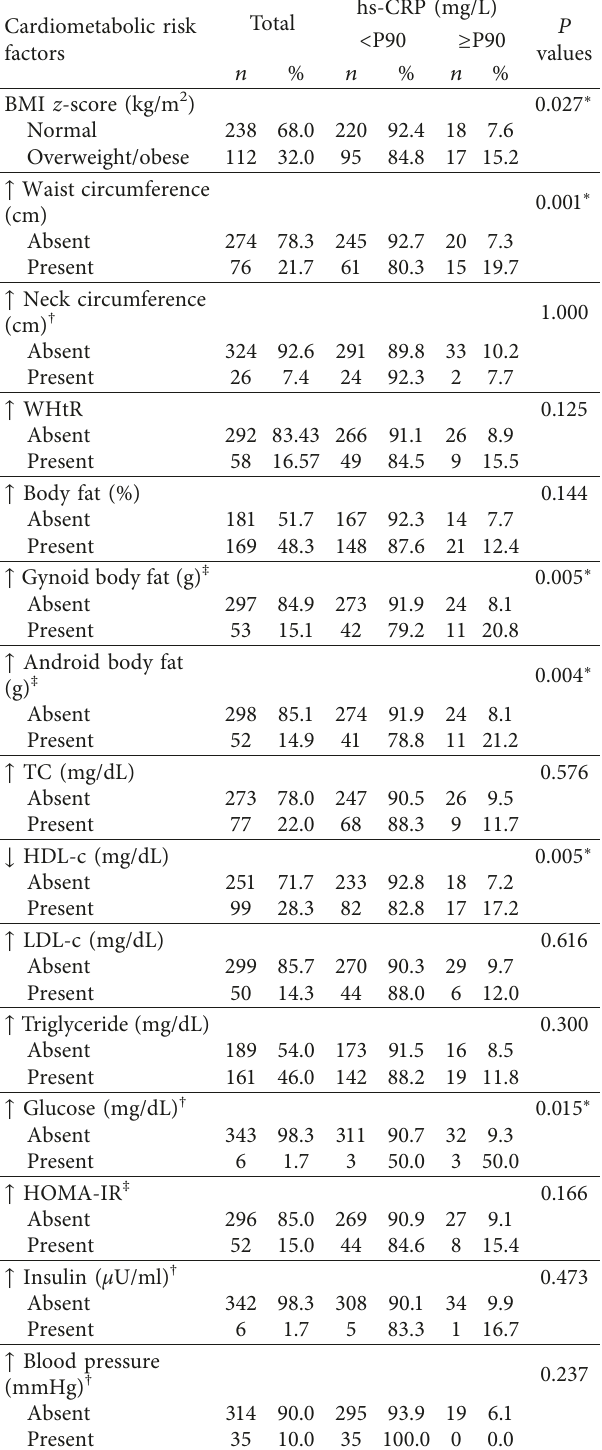
Table 1: Traditional cardiometabolic risk factors of children according to serum hs-CRP concentration, Viçosa, MG, Brazil, 2015.